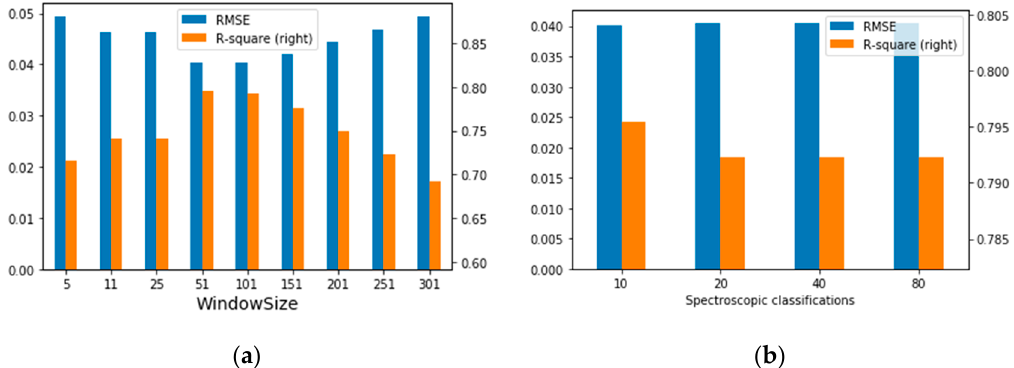
Figure 3. Accuracy comparison of R-square and RMSE between calibrated STARFM-NDVI, Landsat NDVI when spatial and temporal adaptive reflectance fusion model (STARFM) is conducted with ( a ) different window sizes and ( b ) varying the numbers of classes.